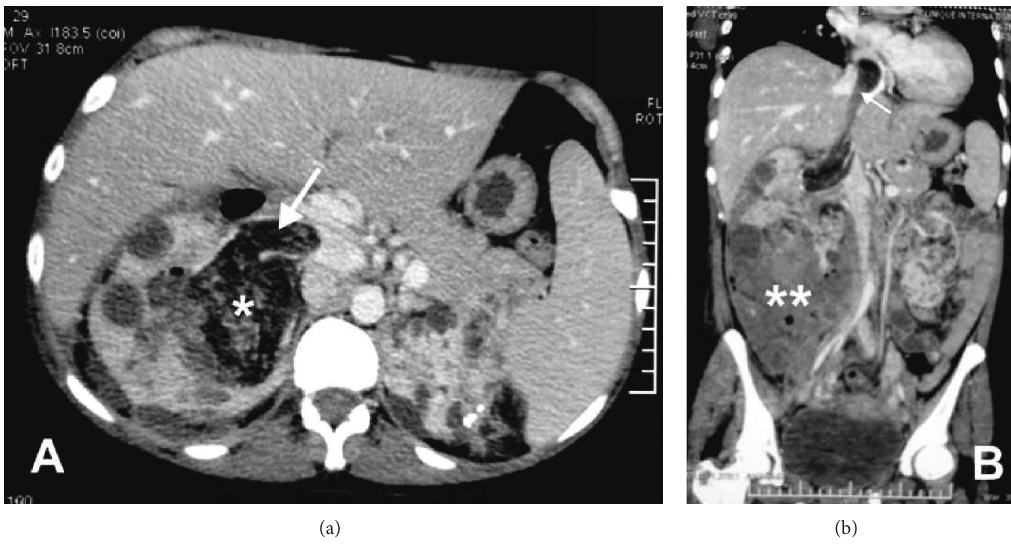
Figure 1: (a) Coronal CT scan showing renal AML ( ∗ ) with inferior vena cava thrombus (arrow). (b) The thrombus extends up to right atrium. Note the presence of a large perirenal infected hematoma due to an old bleeding from lower pole AML ( ∗∗ ).